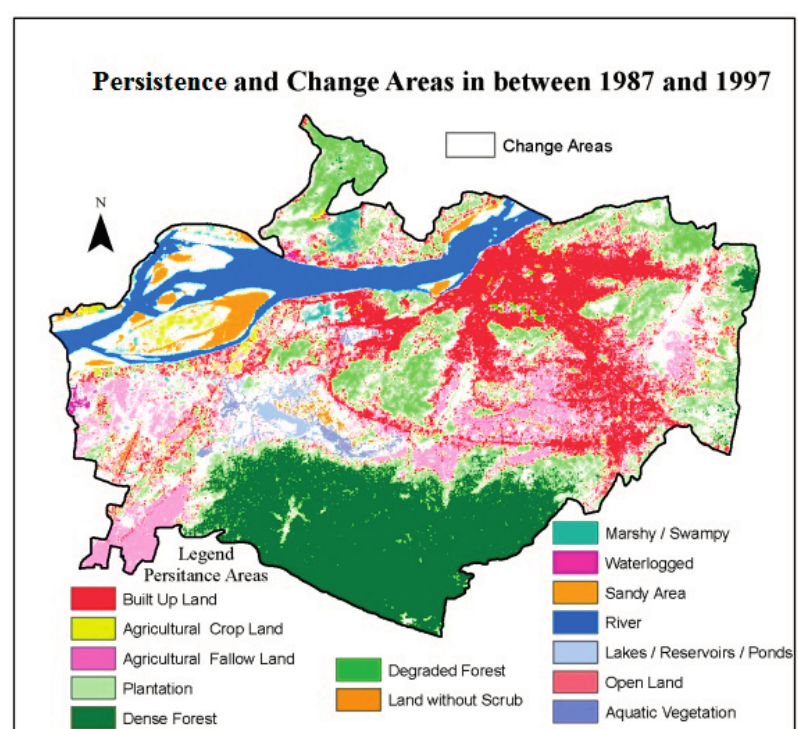
Figure 9. Persistence and change areas between 1987 and 1997.